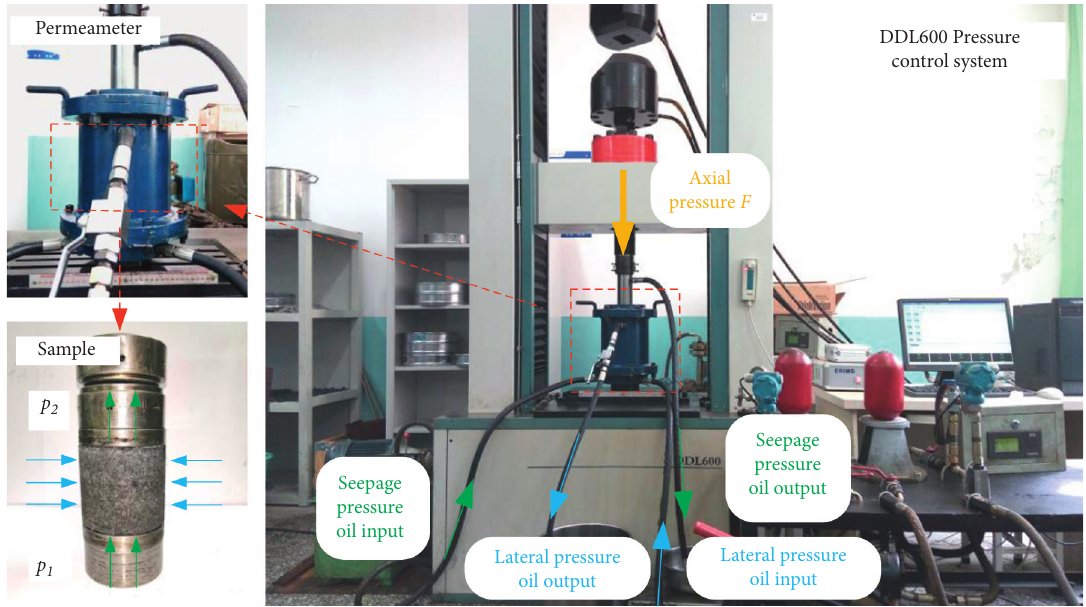
Figure 3: Triaxial seepage test system for cemented fractured coal rock.